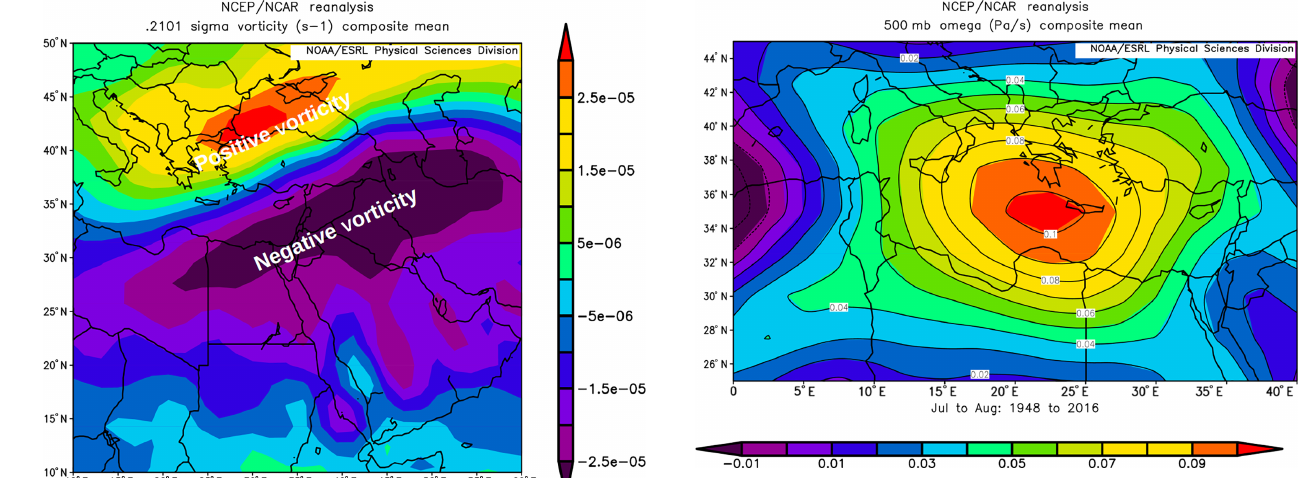
Figure 5. NCEP/NCAR reanalysis long-term averages of omega (Pa s − 1 ) at 500hPa ( ∼ 5 . 5kma . s . l . ) designating vertical motion for July–August 1948–2016. The maximum subsidence of 0.1Pas − 1 is equivalent to a downward air motion of ∼ 1 . 5cms − 1 . NCEP re- analysis data are provided by the NOAA/OAR/ESRL PSD, Boulder, Colorado, USA; http://www.esrl.noaa.gov/psd/.